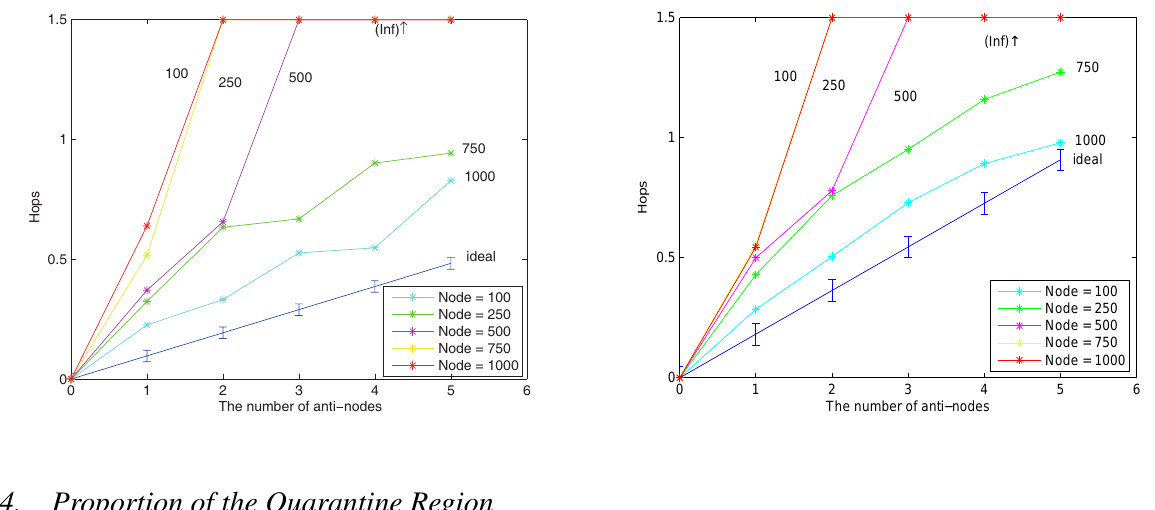
Figure 18. Average extra hops for bypassing routing path and the ideal line of O ≥ 1/3 (Case III) (left), the result and the ideal line of O ≥ 1/5 (Case IV)